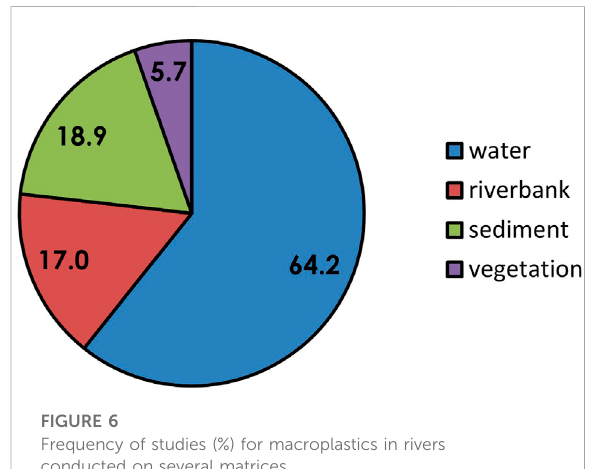
FIGURE 7 Global macroplastic (MA) studies (%) along three river